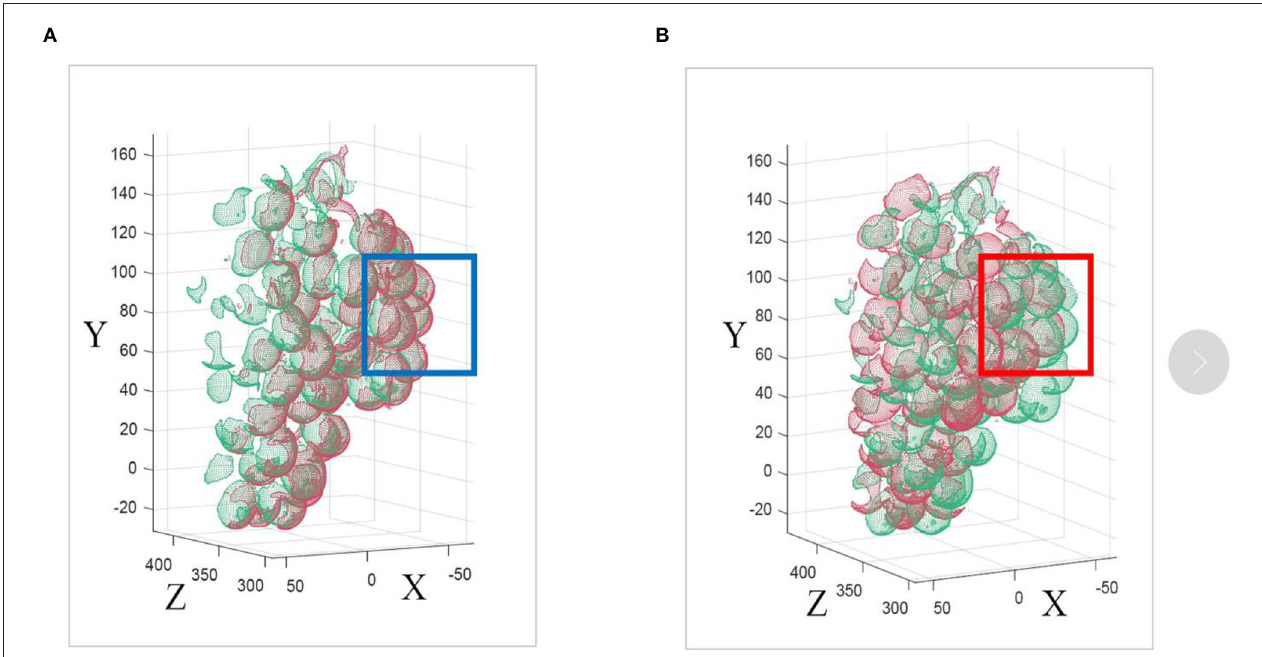
FIGURE 11 | (A) Improved ICP algorithm and (B) traditional ICP